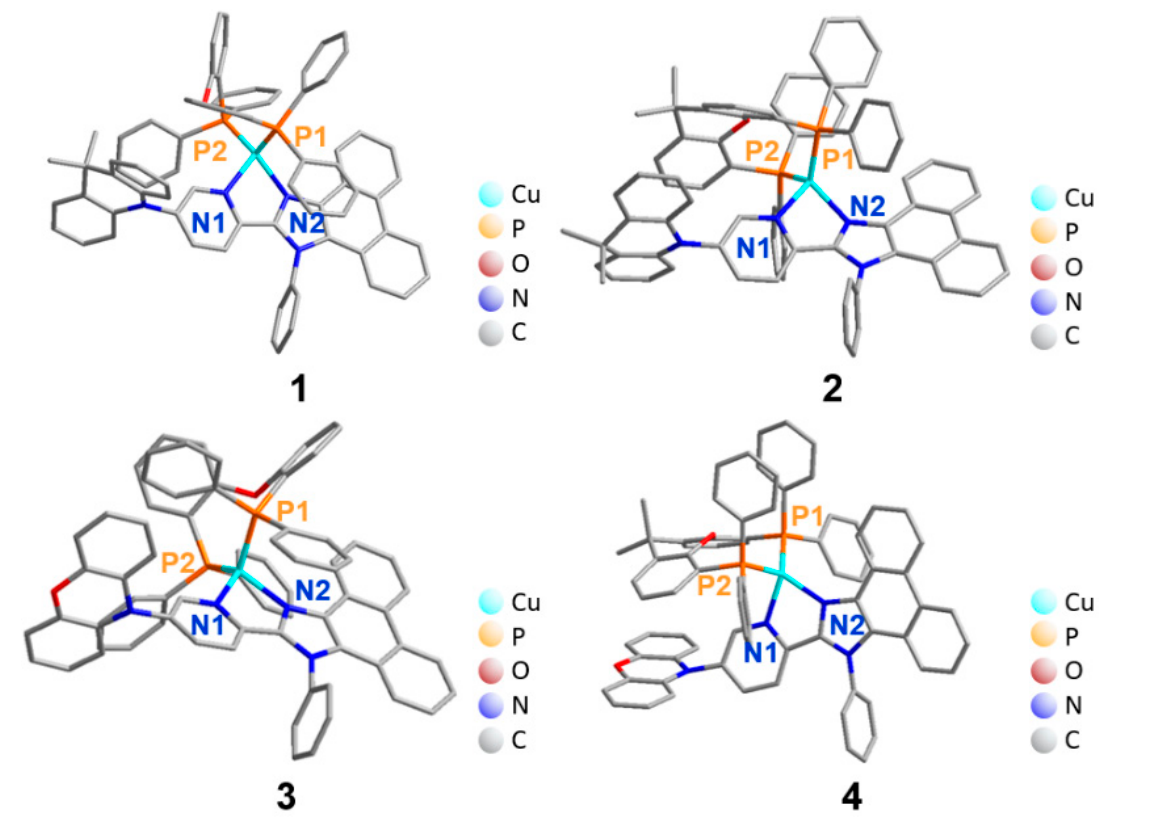
Figure 2. Crystal structures of complexes 1 – 4 .